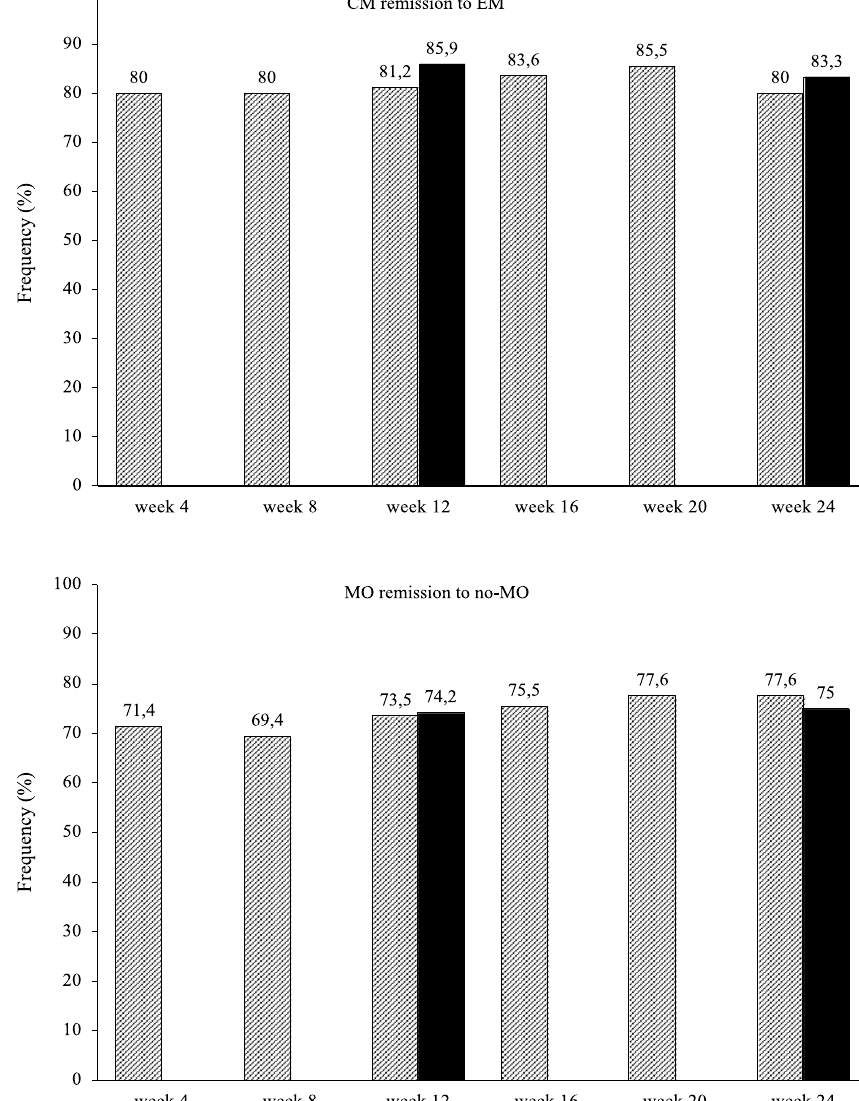
Fig. 7 Proportion of patients remitting from chronic migraine (CM) to episodic migraine (EM) and from medication overuse (MO) to no medication overuse (no-MO). Black bars: patients from headache centers providing data at weeks 12 and 24 ( n 148). Hatched bars: patients from headache = centers providing data at weeks 4, 8, 12, 16, 20 and 24 ( n =